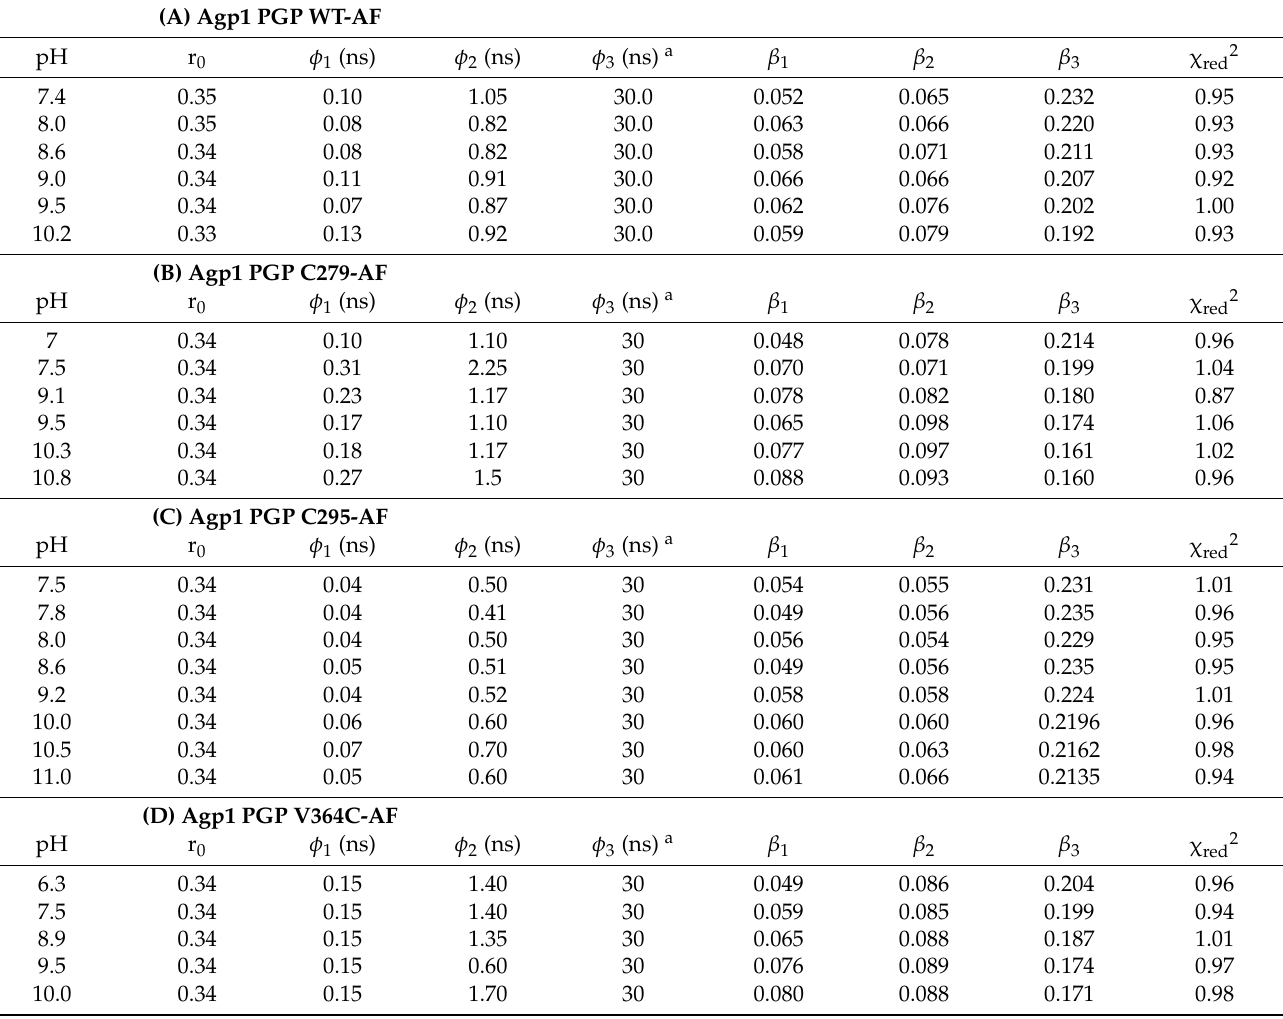
Table 2. Time-resolved anisotropy fit results of Agp1-PGP-AF variants. WT-AF (A), C279-AF (B), C295-AF (C), V364C-AF (D). r 0 is the initial anisotropy and the amplitudes β 1 and β 2 indicate the degree of depolarization of the anisotropy decay components with the correlation times φ 1 and φ 2 , respectively. The tumbling of the whole protein is characterized by φ 3, the corresponding steric restriction by β 3 . The reduced χ 2 ( χ red2 ) is given as a measure of the goodness of the fit.